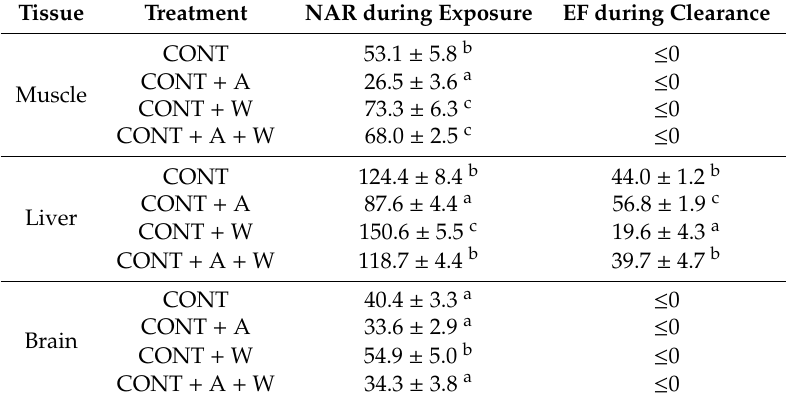
Table 1. Net accumulation rates (NAR, µ g · day − 1 at the end of exposure, i.e., day 28) in fish muscle, liver, and brain, as well as elimination factor (EF, as a percentage, at clearance) in the liver. Tissue